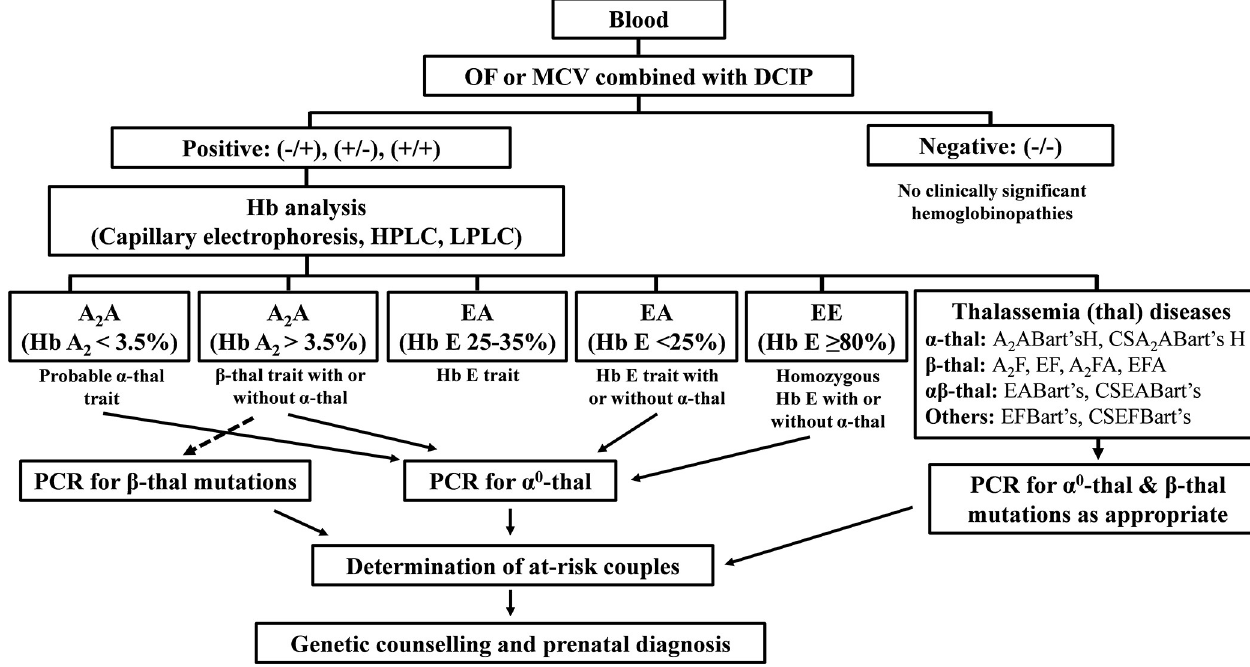
Fig 1. Screening diagram for carriers of α 0 -thalassemia, β -thalassemia and Hb E in Thailand using the combined osmotic fragility (OF) test, MCV and dichlorophenolindophenol (DCIP) test. (Modified from Fucharoen G et al 2004 [6] and Sanchaisuriya K et al 2005 [7]).